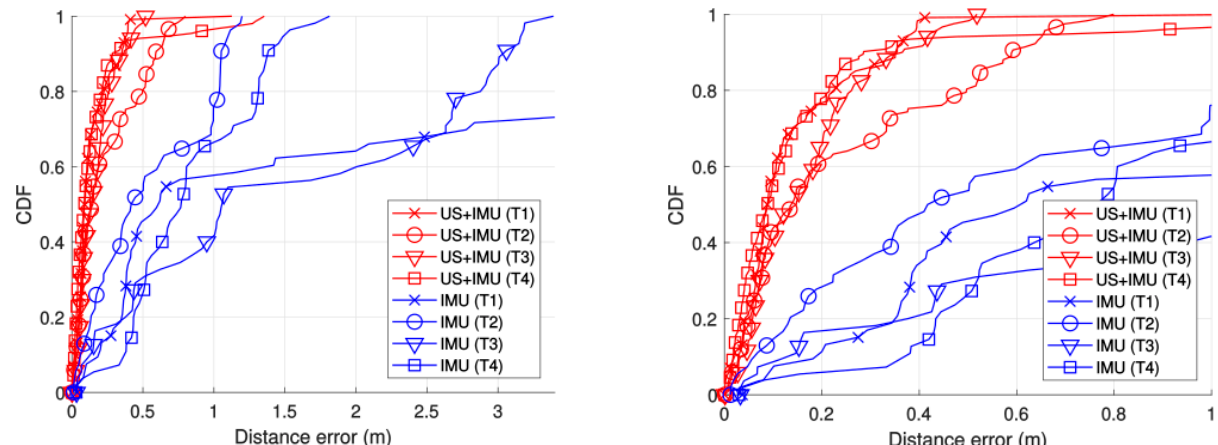
21 of 25 Figure 19. Android screen shots of the experimental tests. In Figure 19, the blue markers represent the first estimated position inside the cover- age area of each U-LPS, the orange markers show the estimated positions by considering